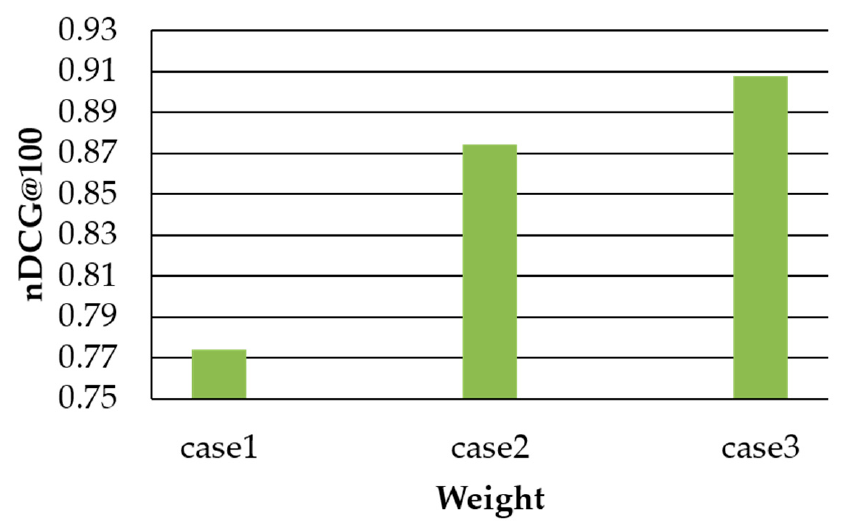
Figure 3. nDCG results based on weight changes.